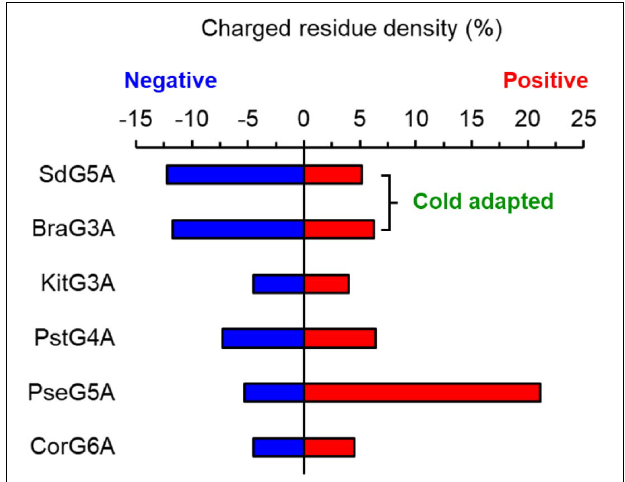
FIGURE 7 | Density of charged amino acid residues in the linker-CBM region of maltooligosaccharide-forming